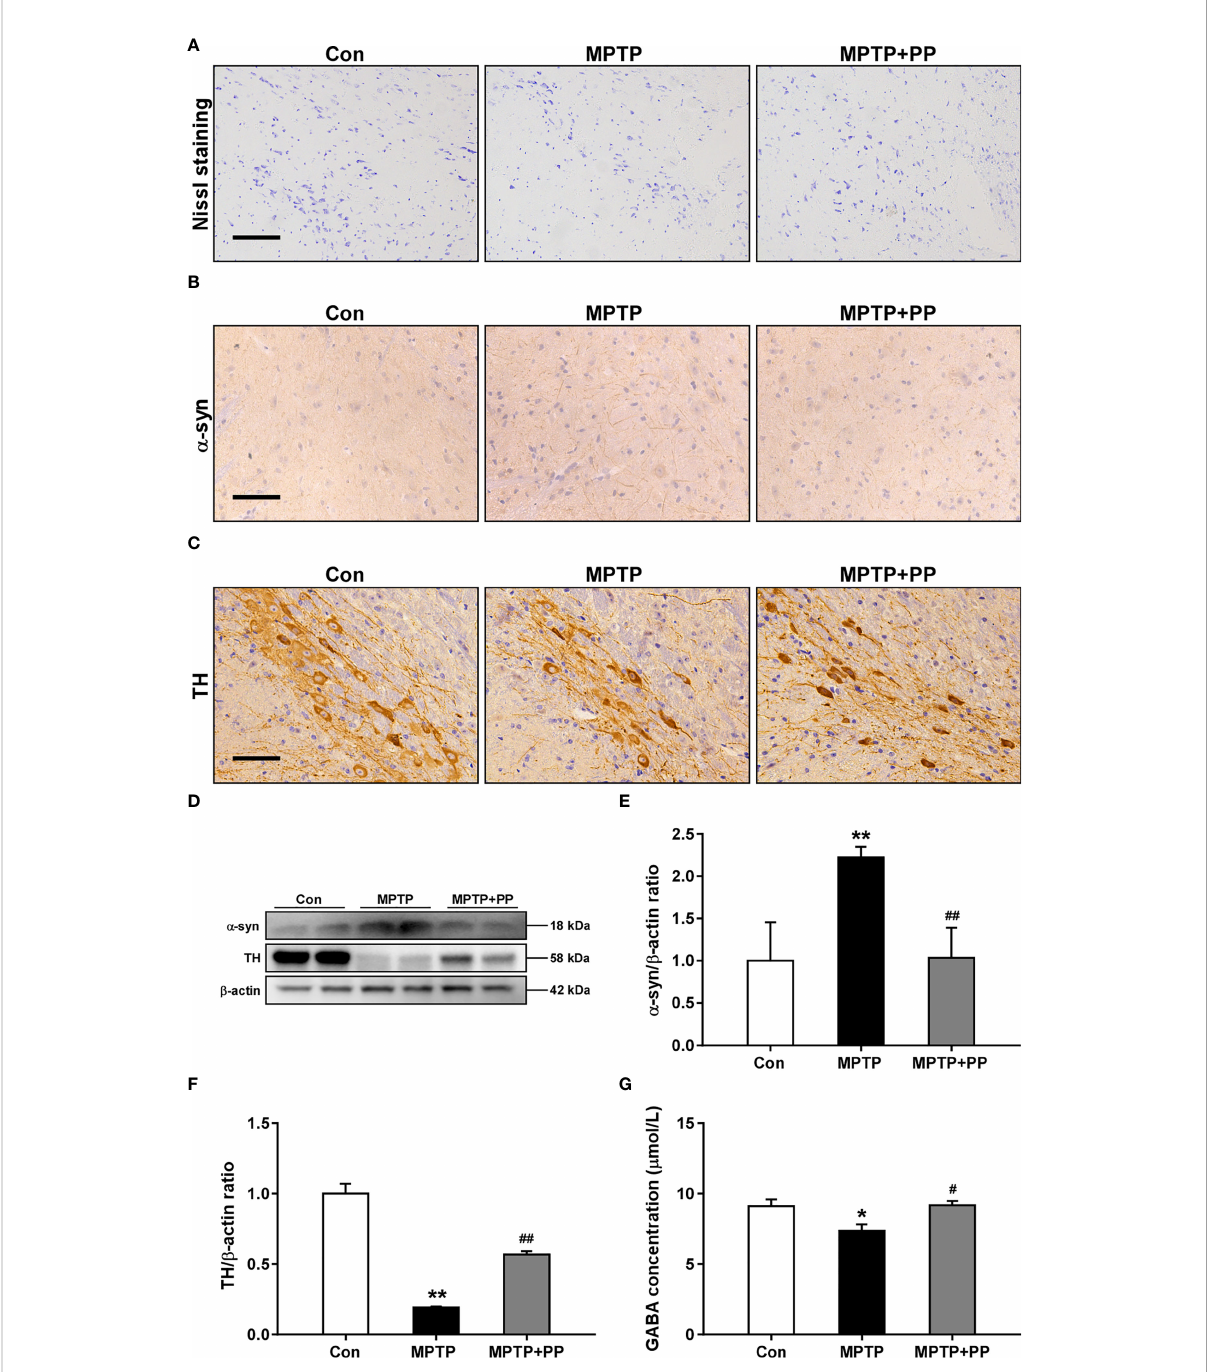
FIGURE 2 Pediococcus pentosaceus treatment attenuated the methyl-4-phenyl-1,2,3,6-tetrahydropyridine (MPTP)-induced neuronal degeneration and the decreased level of g -aminobutyric acid (GABA). (A) Representative images of Nissl staining for Nissl body in neurons. Magni fi cation, ×400; scale bar = 100 m m. (B) Representative immunohistochemistry images of a -synuclein in substantia nigra. Magni fi cation, ×400; scale bar = 100 m m. (C) Representative immunohistochemistry images of TH in substantia nigra. Magni fi cation, ×400; scale bar = 100 m m. (D) Representative Western blotting images of a -synuclein ( a -syn) and TH. (E) Quantitative analysis of a -syn. (F) Quantitative analysis of TH. b -actin was used as the internal reference. (G) Quantitative analysis of the GABA level in the brain. Statistical comparison by one-way ANOVA with post-hoc comparisons of Dunnett ’ s multiple-comparisons test. Data are presented as means ± SEM; n = 4 – 6 per group. * P < 0.05 vs . Con group, ** P < 0.01 vs . Con group, # P < 0.05 vs . MPTP group, ## P < 0.01 vs . MPTP